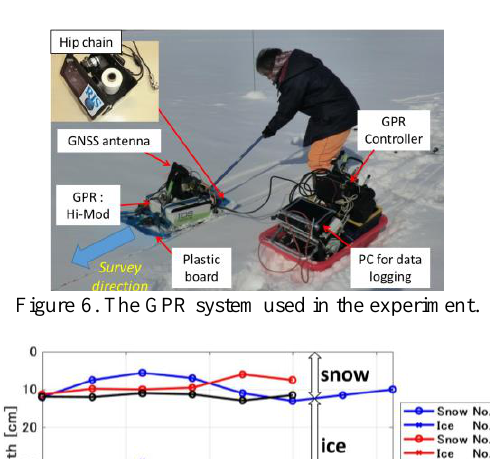
Figure 5. Test field located in the west side of the lake. (a) Sattellite image indicated by rectangular in Figure 4. (b) Crack arround the area. (c) GPR survey line arround the rectanguler in (a). The arrows indicate scan direction.